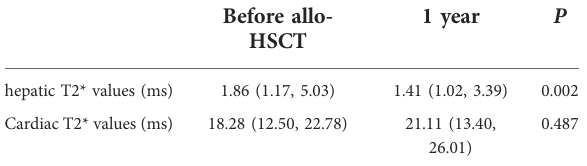
TABLE 6 T2* MRI values before and after HSCT. Before allo-